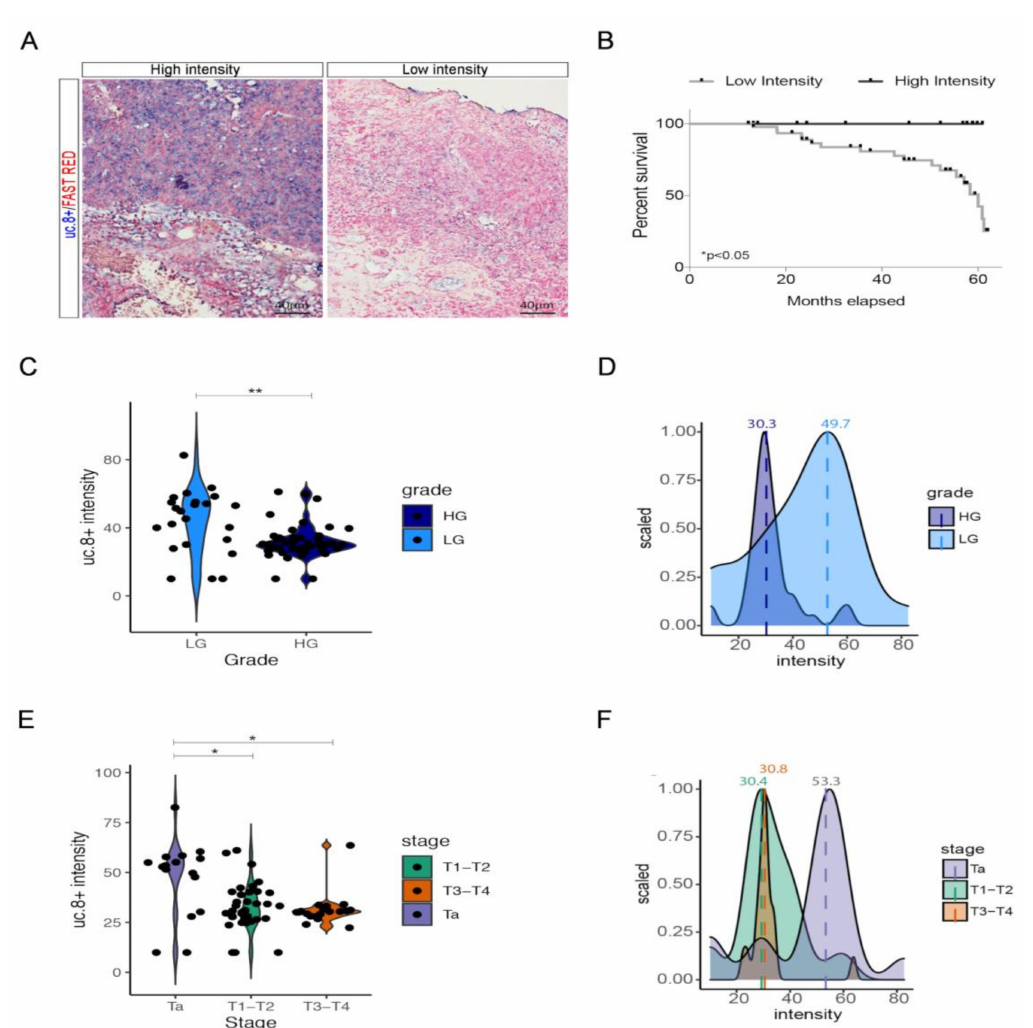
Figure 1. ( A ) Representative pictures of RNA in situ hybridization of uc.8+ in BlCa pts. ( B ) Survival plot of pts with low and high uc.8+ intensity. ( C ) Violin plot showing uc.8+ intensity score values across tumor grade and ( D ) frequency plot showing the scaled distribution of uc.8+ intensity value according to the patient grade and their relative median values (high grade = 30.3; low grade = 49.7). ( E ) Violin plot showing uc.8+ intensity score values across tumor stage and ( F ) frequency plot showing the scaled distribution of patient uc.8+ intensity value according to the stage and their relative median values (Ta = 53.3; T1–2 = 30.4; T3–4 = 30.8). * p -values < 0.05, ** p -values <